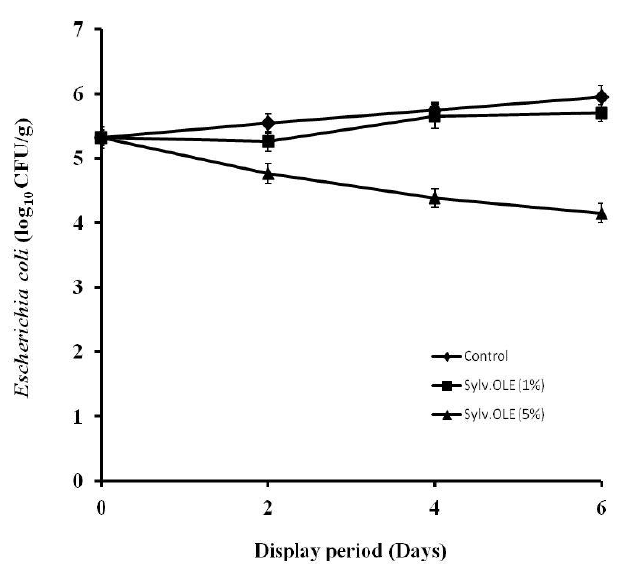
Figure 3. Escherichia coli O157:H7 growth rate in HMB during display in the presence of different sylv . OLE concentrations.